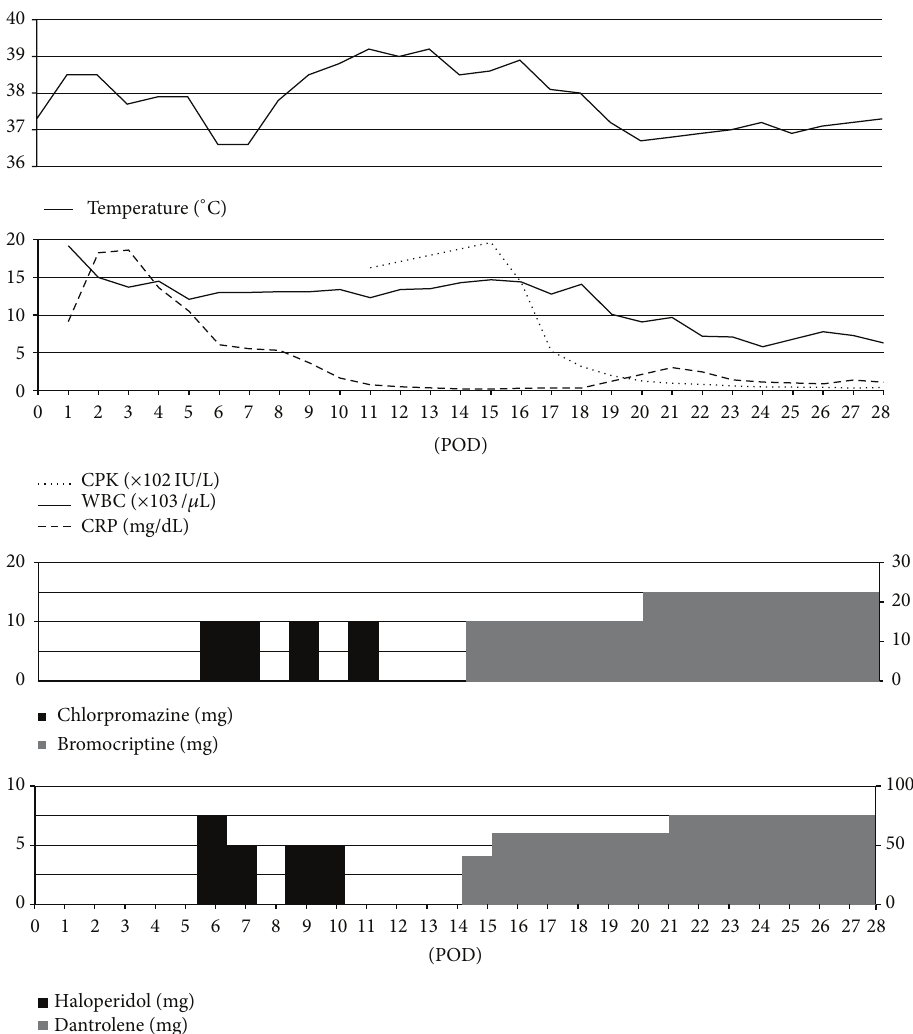
Figure 1: Clinical course of NMS. POD: postoperative days. On POD 15, treatment of NMS began.